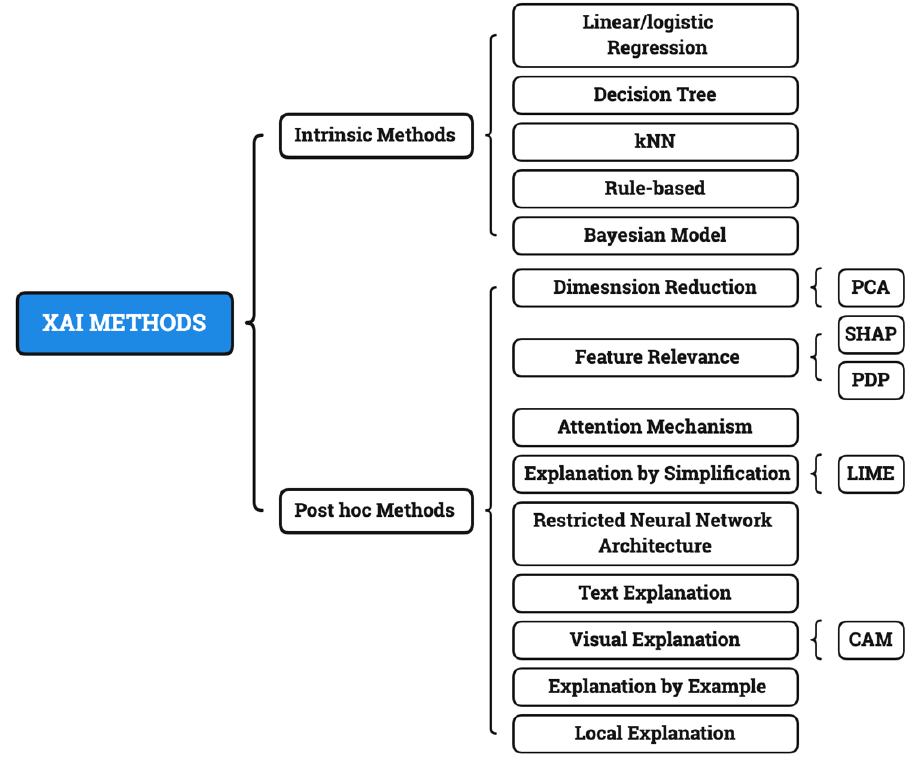
Figure 2. Taxonomy of XAI methods, post hoc XAI types, and some examples.